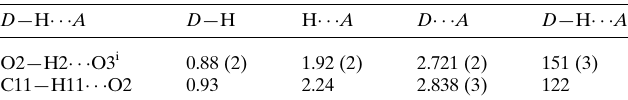
Table 1 Hydrogen-bond geometry (A˚ , (cid:4)